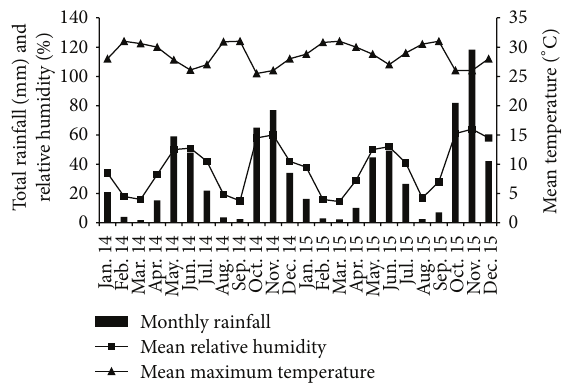
Figure 2: Variation in total monthly rainfall, mean maximum temperature, and mean soil moisture